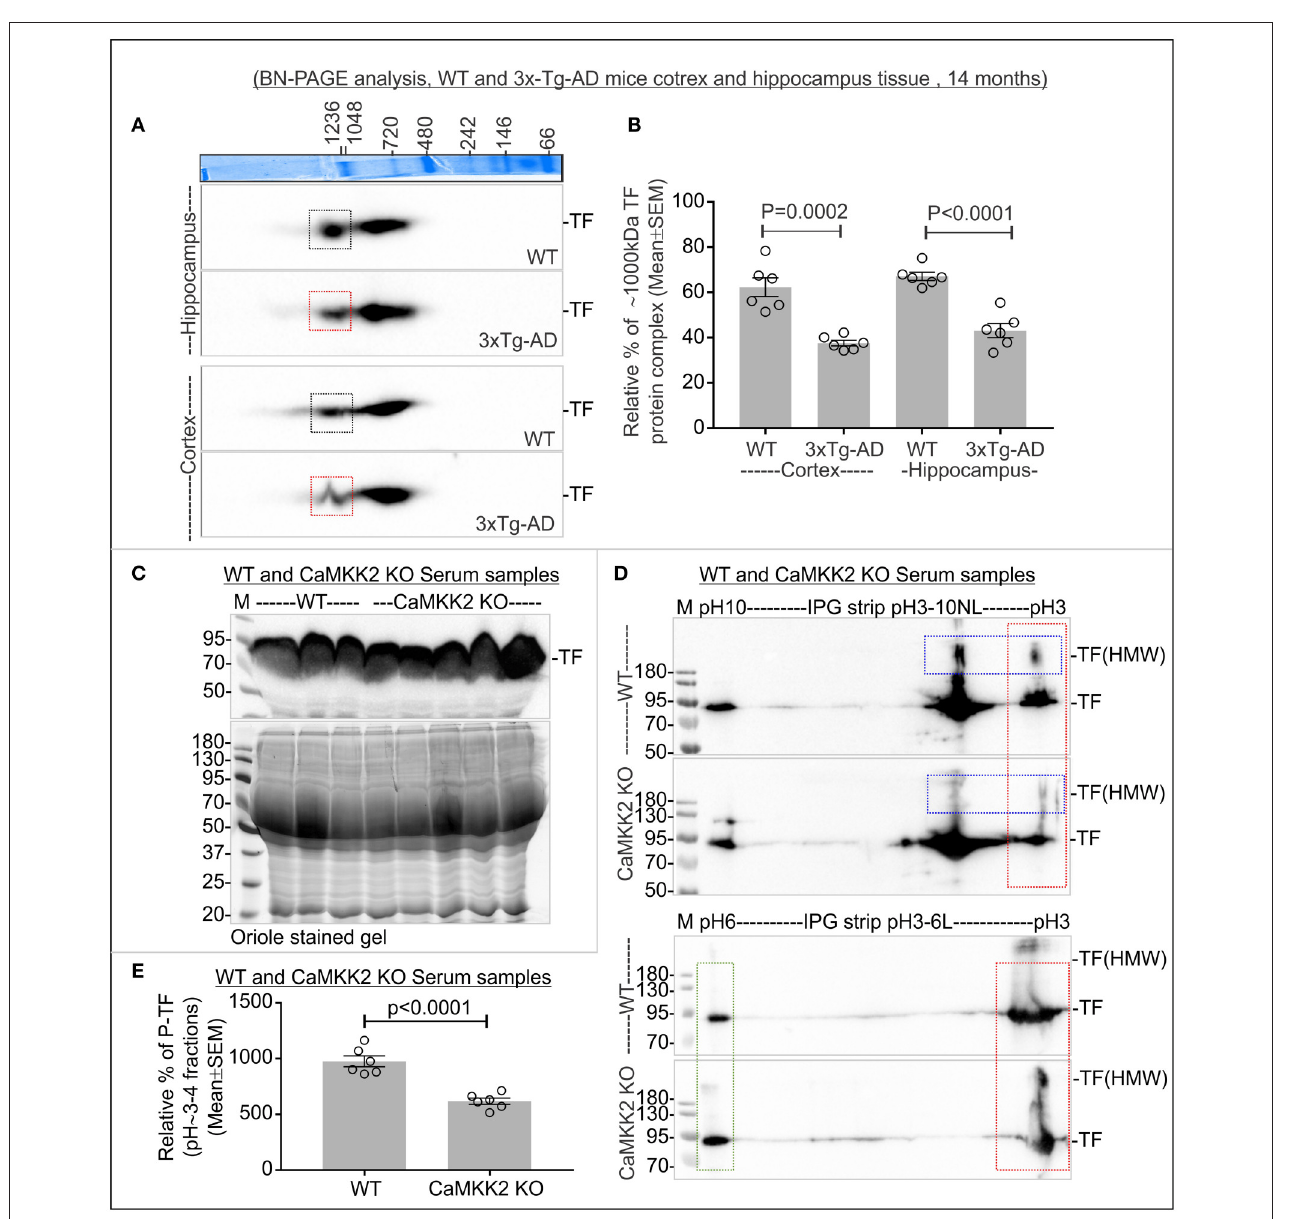
FIGURE 8 | Altered TF associated protein complexes in 3xTg-AD mice cortex and hippocampus, and significantly reduced P-TF in CaMKK2 KO mice serum. (A) Immunoblots showing TF associated MPCs in the cortex and hippocampus tissues from 14 months old wild-type and 3xTg-AD mice. The Coomassie stained gel strip on the top panel showing native page molecular weight ladder. Colored squares represent a change in the relative intensity. (B) Scatter plot showing relative intensities of ∼ 1,000 kDa TF associated MPC. The intensity of the ∼ 720 kDa complex was used for normalization. (C) Immunoblot showing total TF level in the serum (top panel). Bottom panels: SDS-PAGE gel stained with Oriole to show total protein loading. (D) Immunoblots showing charged fractions of TF in the serum. Proteins were focused on IPG pH3-10NL strips (top panel) and IPG pH3-6L strips (bottom panel), respectively. The red dotted rectangle indicates P-TF (pH ∼ 3-4 fractions). Blue dotted rectangles indicate HMW TF. (E) Scatter plot showing relative abundance of P-TF in serum. The pH ∼ 3-4 fractions were normalized on the basis of pH ∼ 6 fraction intensities (green rectangle) in IPG pH3-6L strips. N = 6 replicates from 3 mice in all experiments. The p -value by t -test (unpaired).